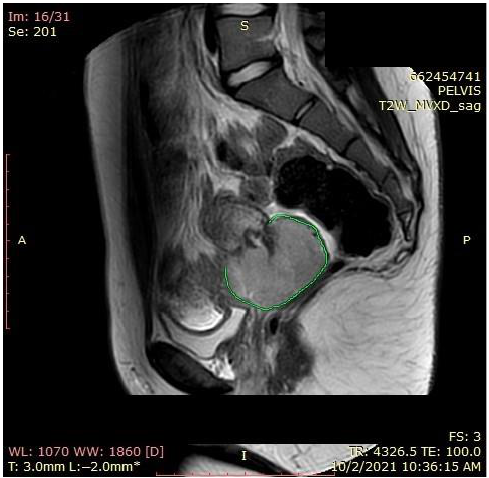
Figure 1. Pelvic sagittal T2 – weighted sequence: the green highlighted area represents the circum- ferentially developed cervical tumor mass with intermediate T2 signal that includes both the endo- and the ectocervix protruding into the upper vagina.